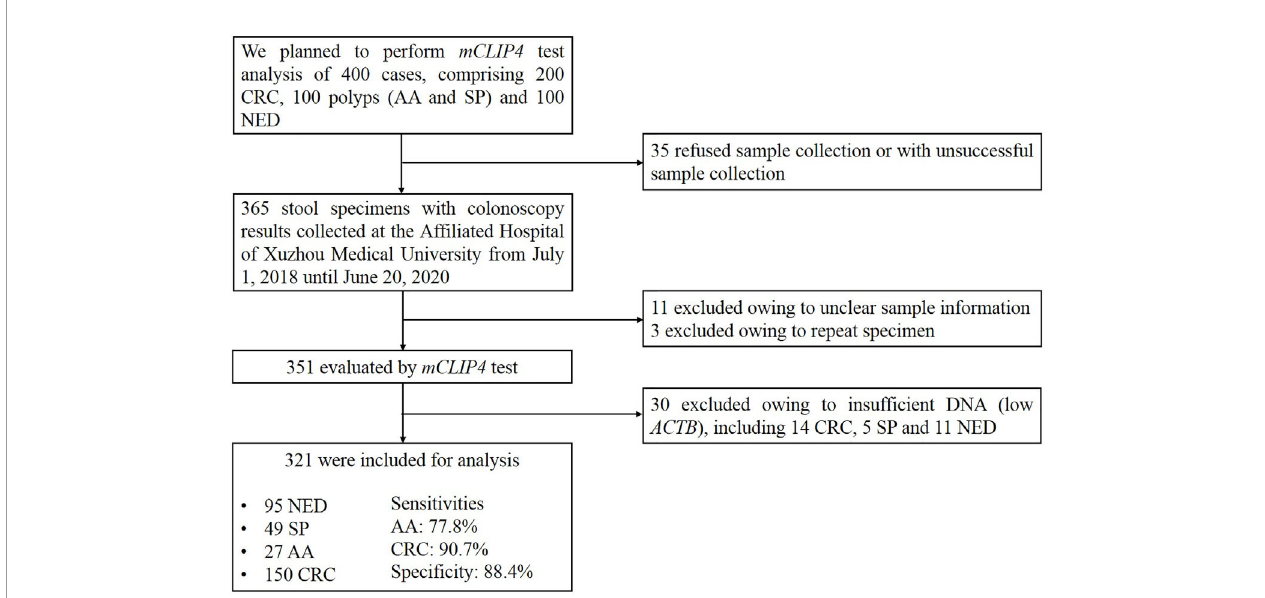
FIGURE 1 | Flow diagram of the